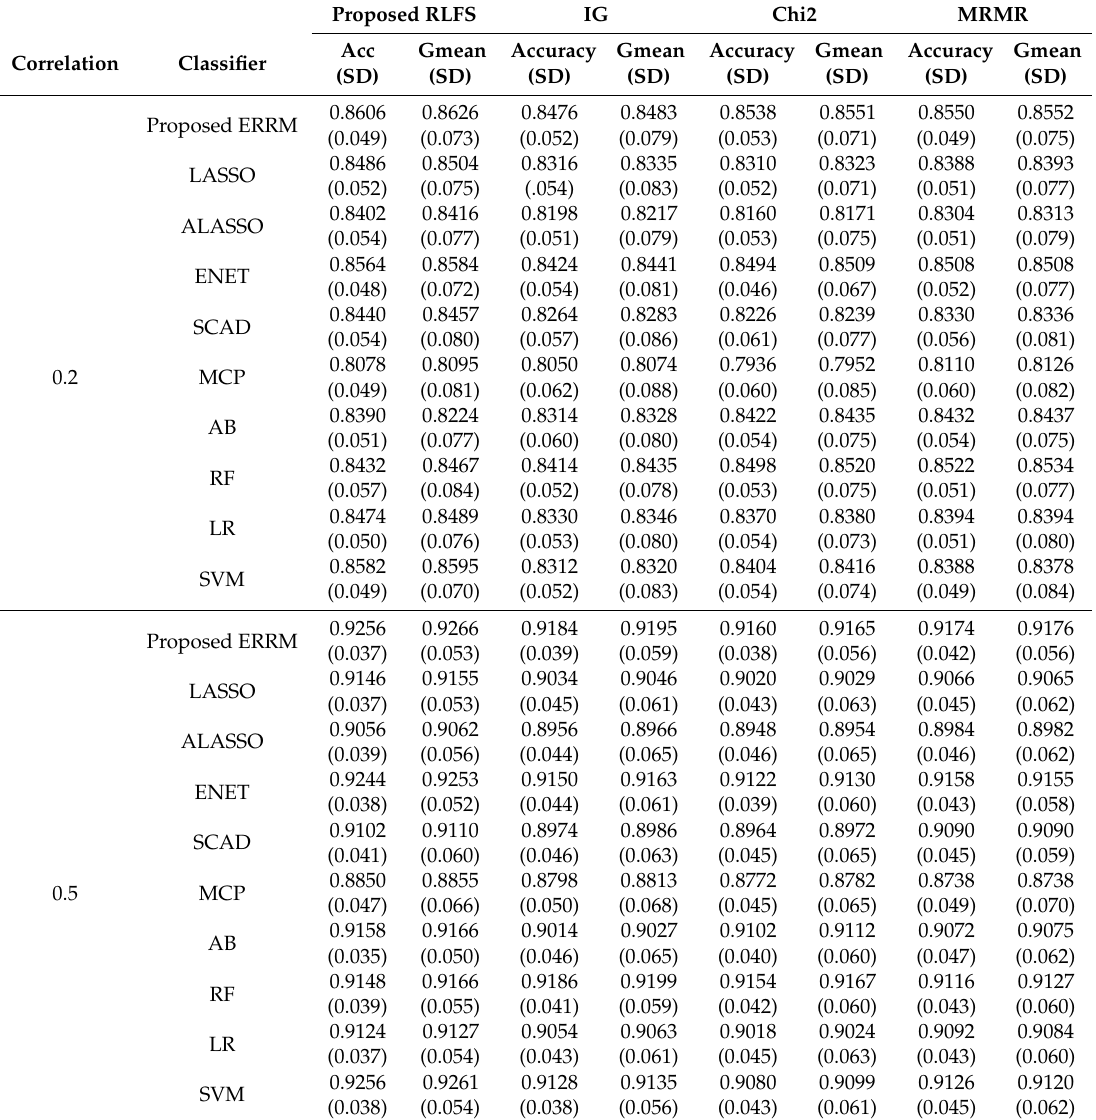
Table 1. Classification performance of proposed RLFS with ERRM compared to other combinations of feature selection methods with classifiers over 100